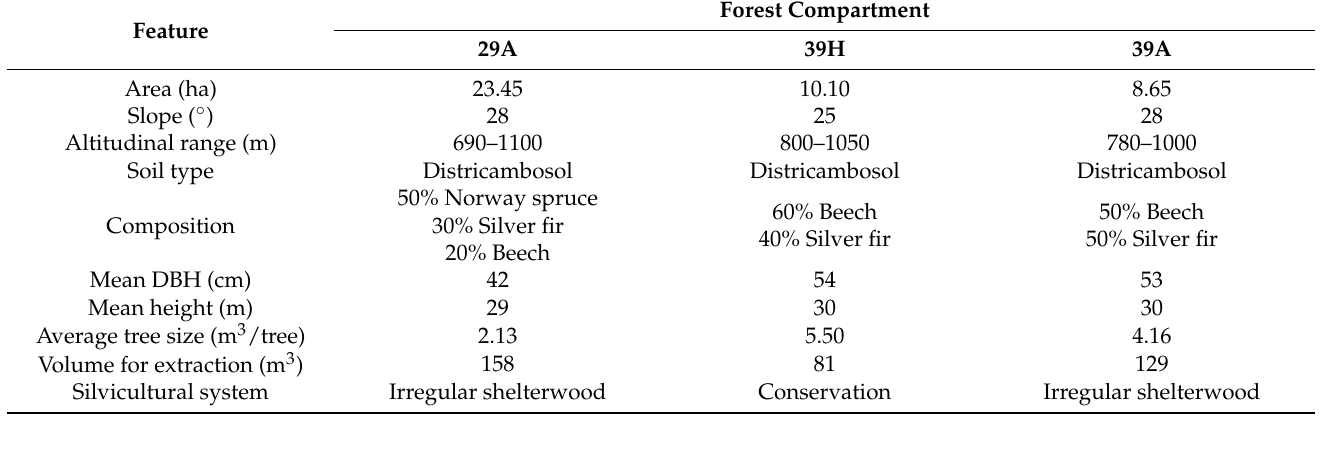
Table 1. Description of the compartments taken into study.